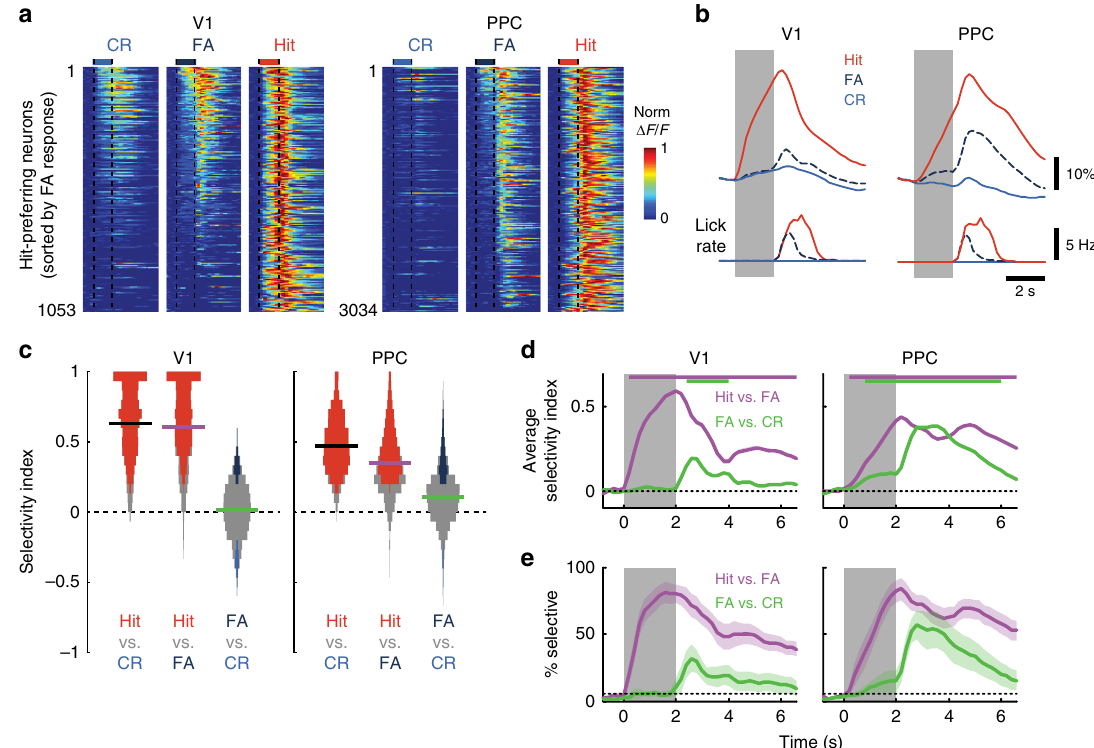
Fig 3 Error trials reveal sensitivity of PPC to both stimulus and choice. Only Hit-preferring neurons were used in all panels of this fi gure. a Trial-averaged responses during False Alarm (FA) trials, for recordings with at least fi ve FA trials, in V1 (left; 1053 neurons across 16 sessions) and in PPC (right; 3034 neurons across 21 sessions). Responses for each neuron are normalized by peak response across Correct Reject (CR, left, blue), FA (center, dark blue), and Hit trials (right, red). Neurons are sorted by descending strength of FA response. Vertical dashed lines demarcate duration of stimulus. b Population trial- averaged responses (top) during Hit, FA (dashed), and CR trials, for V1 (left) and PPC (right). Average lick rate (bottom). c Violin plots